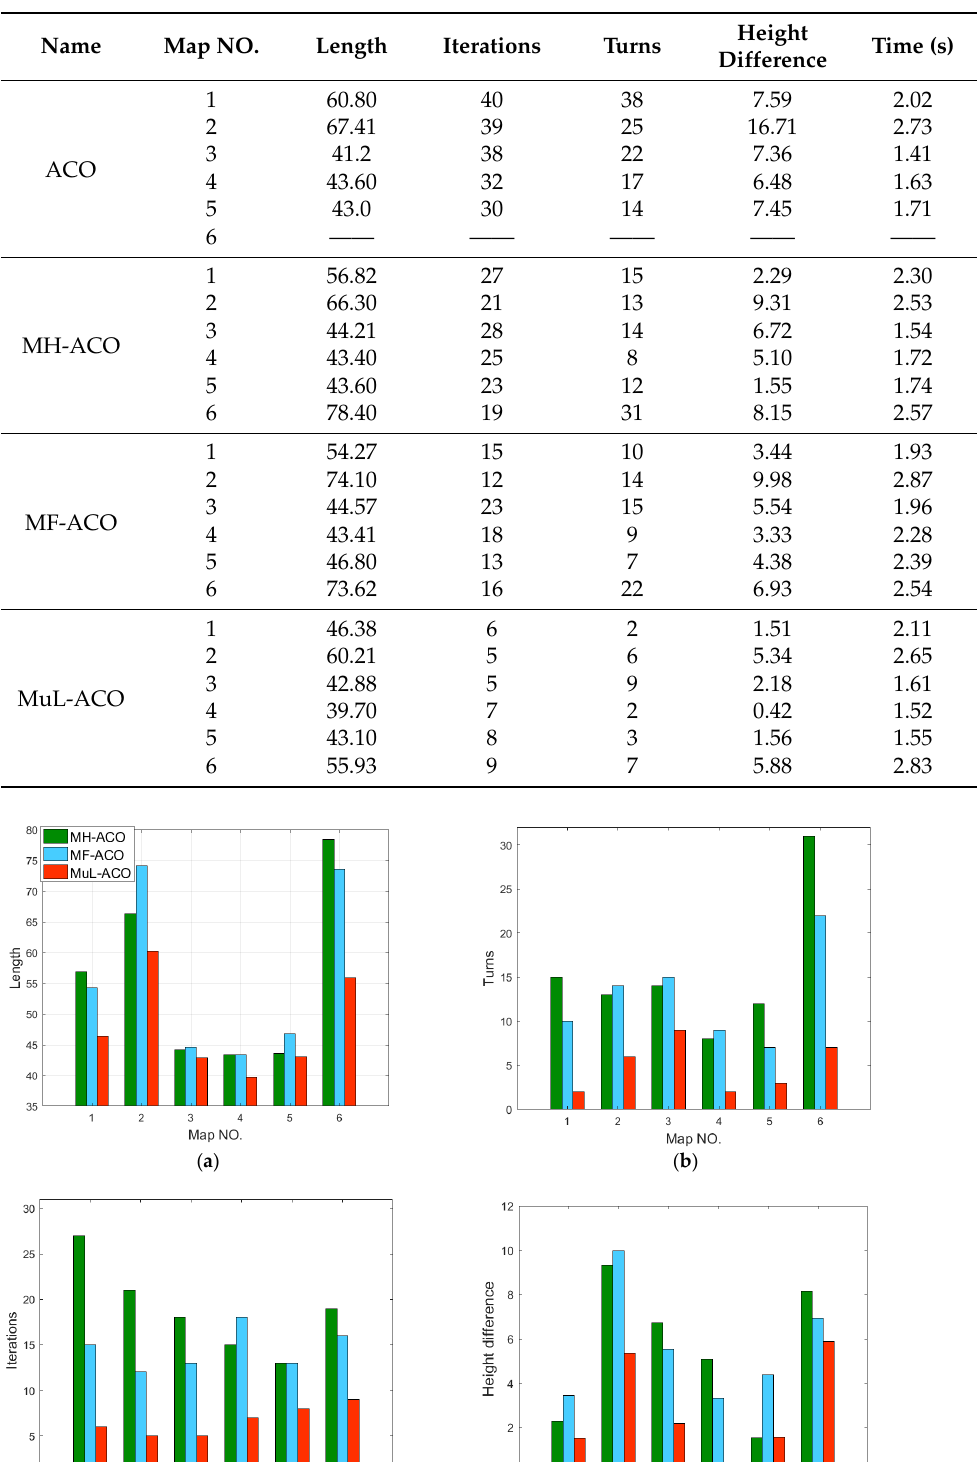
Table 4. Simulation results of ACO, MH-ACO, MF-ACO, and MuL-ACO.